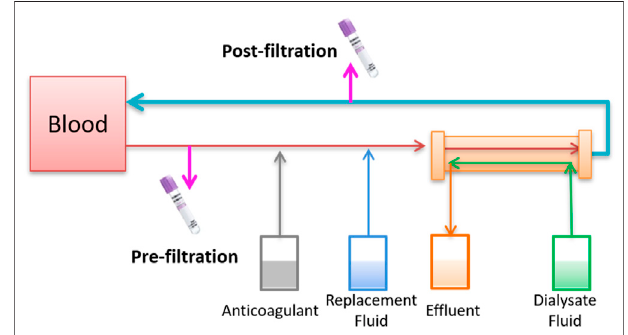
( Figure 2 ). The same type of hemo fi lter membrane was used